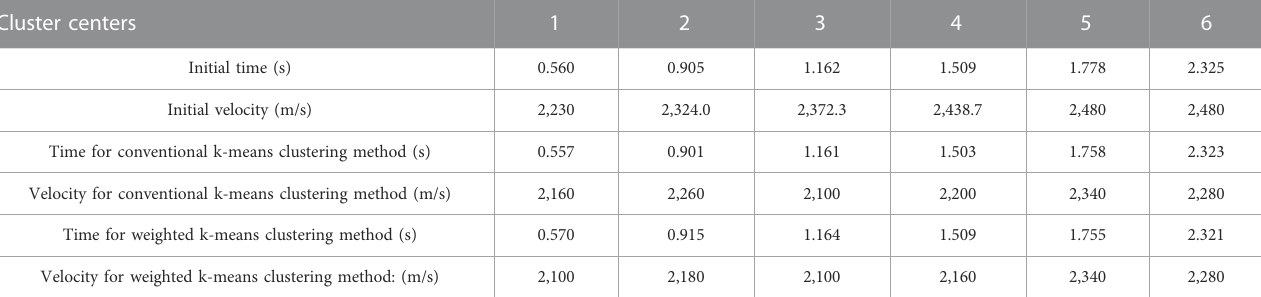
TABLE 1 Initial value and picking result of cluster